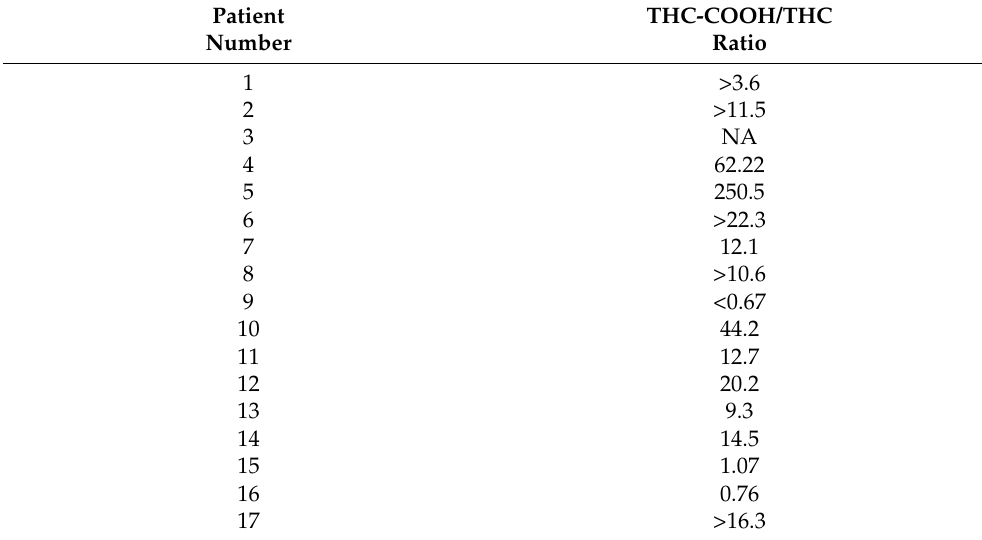
Table 2. THC-COOH/THC concentration ratios in plasma samples determined by GC/MS. Ratios were calculated by forming the quotients of the THC-COOH and THC concentrations of each plasma sample. NA: not applicable, as both concentrations were below the LOQ.